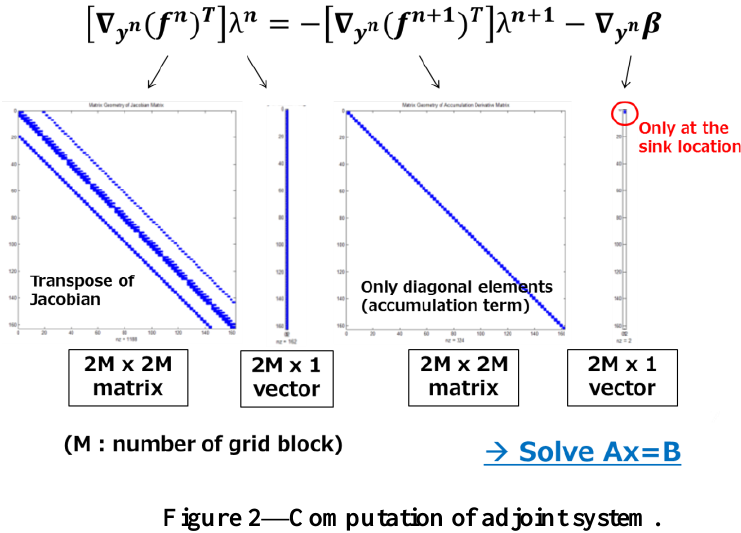
Figure 2—Computation of adjoint system.